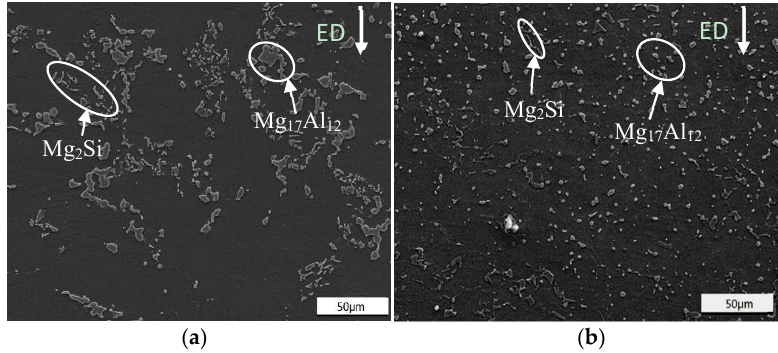
Figure 4. SEM micrographs of ECAPed Mg-9Al-1Si-1SiC composites: ( a ) without HT; ( b ) with HT. ED: extrusion direction.